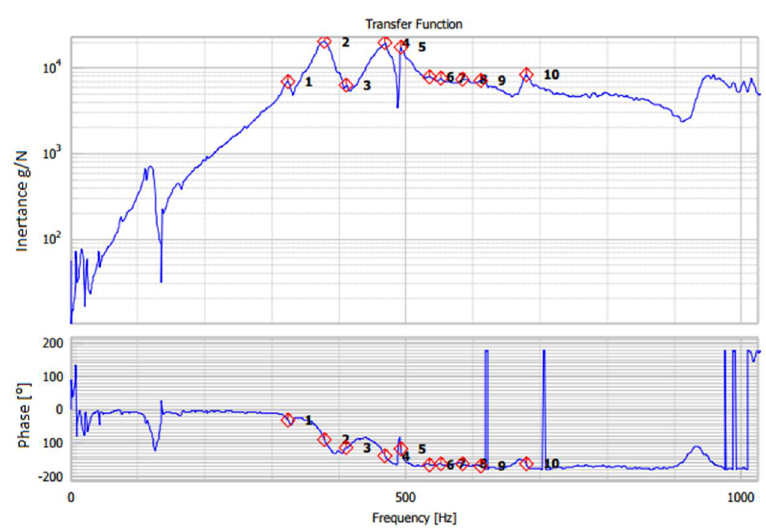
Figure 17. Frequency response function.